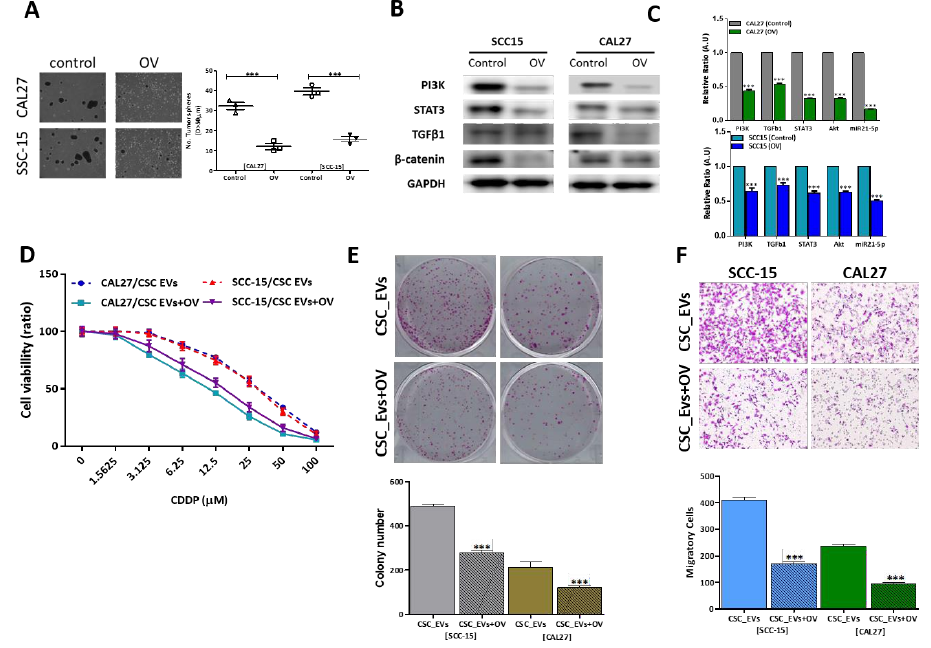
Figure 4. Ovatodiolide (OV) treatment suppresses tumorigenesis via reduction of the exosomal cargo. ( A ) OV treatment (4 µM, 48 h) significantly reduced the number of tumor spheres generated in both the CAL27 and SCC-15 cell lines. ( B ) Western blots show that OV treatment suppressed phosphatidylinositol-3 kinase (PI3K), signal transducer and activator of transcription 3 (STAT3), transforming growth factor (TGF)-β1, and β-catenin in tumor spheres generated after OV treatment. ( C ) OV treatment led to significantly reduced mRNA levels of PI3K, TGF-β1, Akt, STAT3, and miR-21-5p in cancer stem cell (CSC)_extracellular vesicles (EVs), compared to their control counterparts. a, p < 0.01; b, p < 0.001. CSC_EVs isolated after OV treatment showed reduced cisplatin (CDDP) resistance ( D ), and significantly suppressed colony-forming ( E ) and migratory ( F ) abilities. ** p < 0.01; *** p < 0.001.